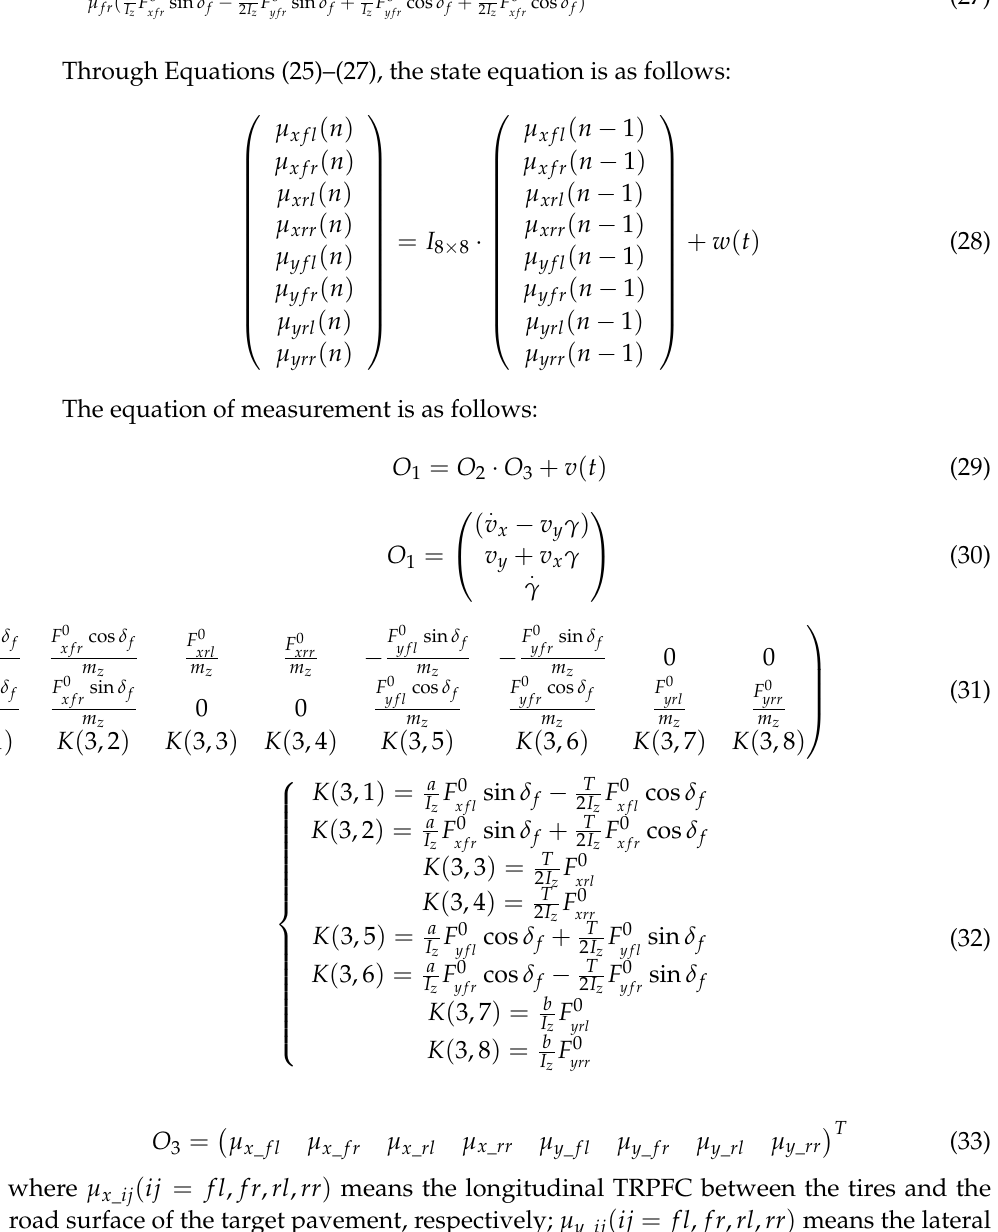
the corresponding covariance matrix is set as P 0 = 0.1 · I 4 × 4